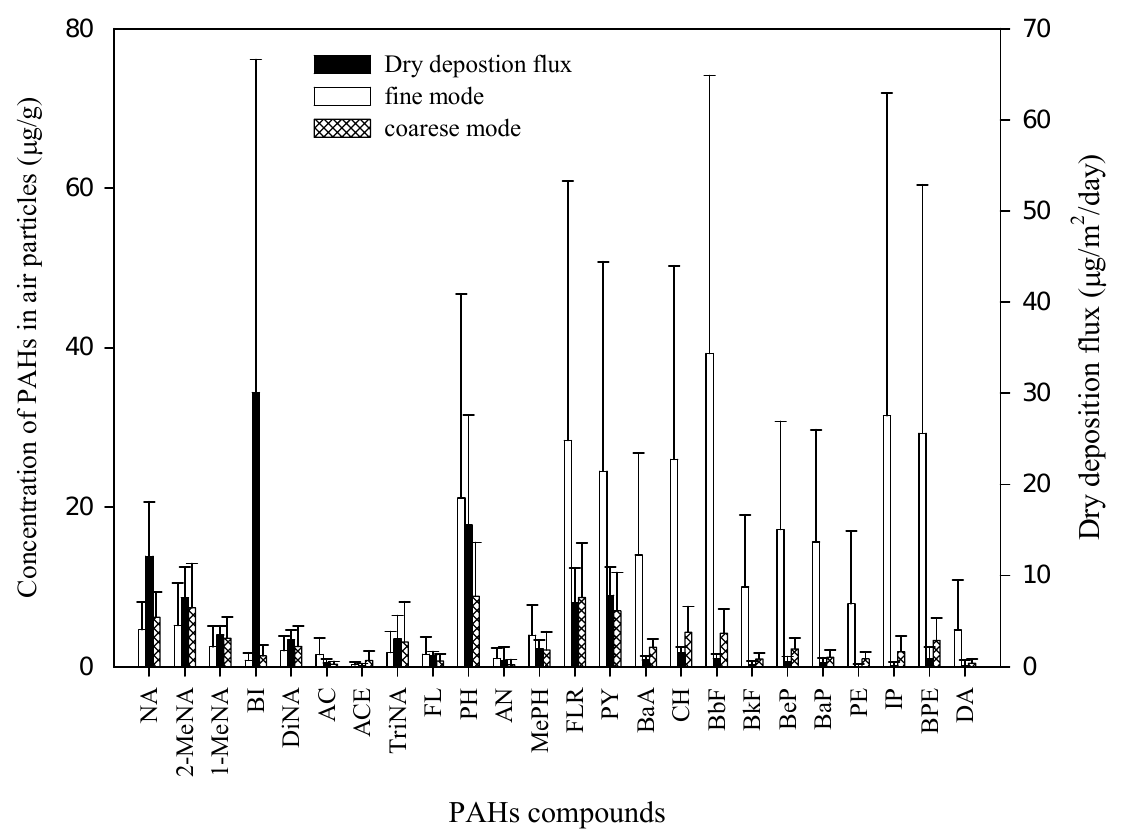
Figure 7. Annual average concentration of PAHs in PM (fine mode: <3 μ m, coarse mode: >3 μ m) and dry deposition fluxes. Error bars denote one standard